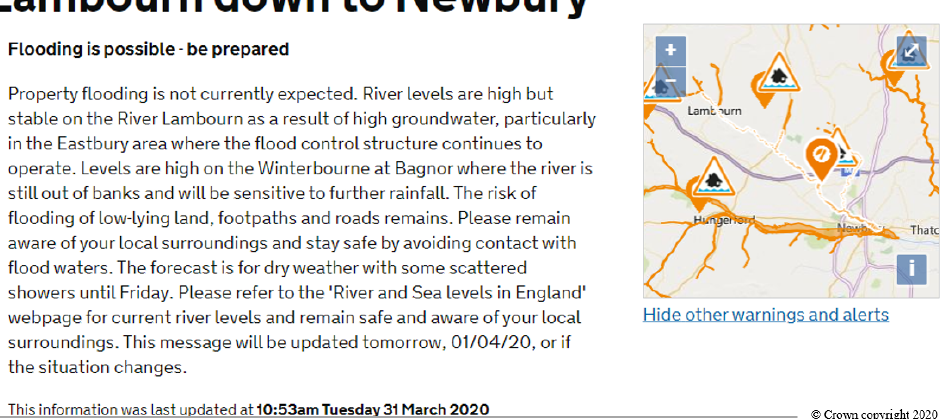
Figure B1. Visual examples of current operational forecast products and fluvial flood forecast messages and products used and produced by EA MFDOs and FWDOs for various dates in the past: (a) Flood Guidance Statement, (b) Hydro-meteorological Guidance, (c) Forecast Meteorological Data, (d) Rainfall Scenario Map, (e, f) Heavy Rainfall Alert, (g) “best estimate” (BE) and “reasonable worst case” (RWC) rainfall and water level scenarios on the NFFS, (h) written description of the two forecast scenarios (the “best estimate” BE and the “rea- sonable worst case” RWC) from an MFDO, (i) EA flood alerts and warnings to the public, and (j) fluvial flood alert message to the public. Sources: panels (a) – (h) were obtained from the EA, and panels (i) and (j) were obtained from Twitter and the EA active warnings website: https://flood-warning-information.service.gov.uk/warnings (last access: 10 August 2020), respectively. Note that these examples are not for the same dates as these were not